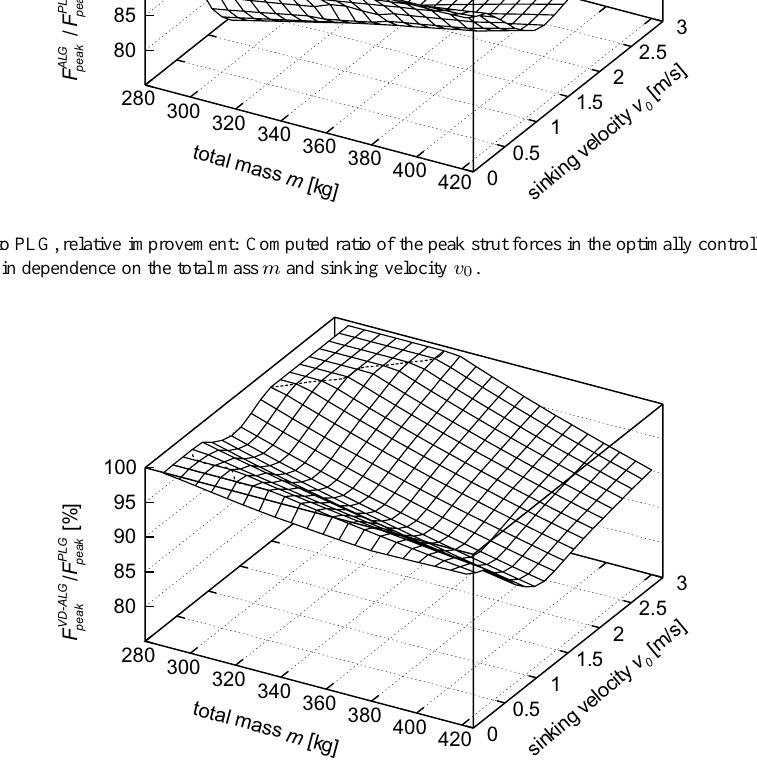
Fig. 11. VD-ALG compared to PLG, relative change: Computed ratio of the peak strut forces in the optimally controlled VD-ALG and PLG at the same landing conditions, in dependence on the total mass m and sinking velocity v 0 ; the contour line marks the 100%